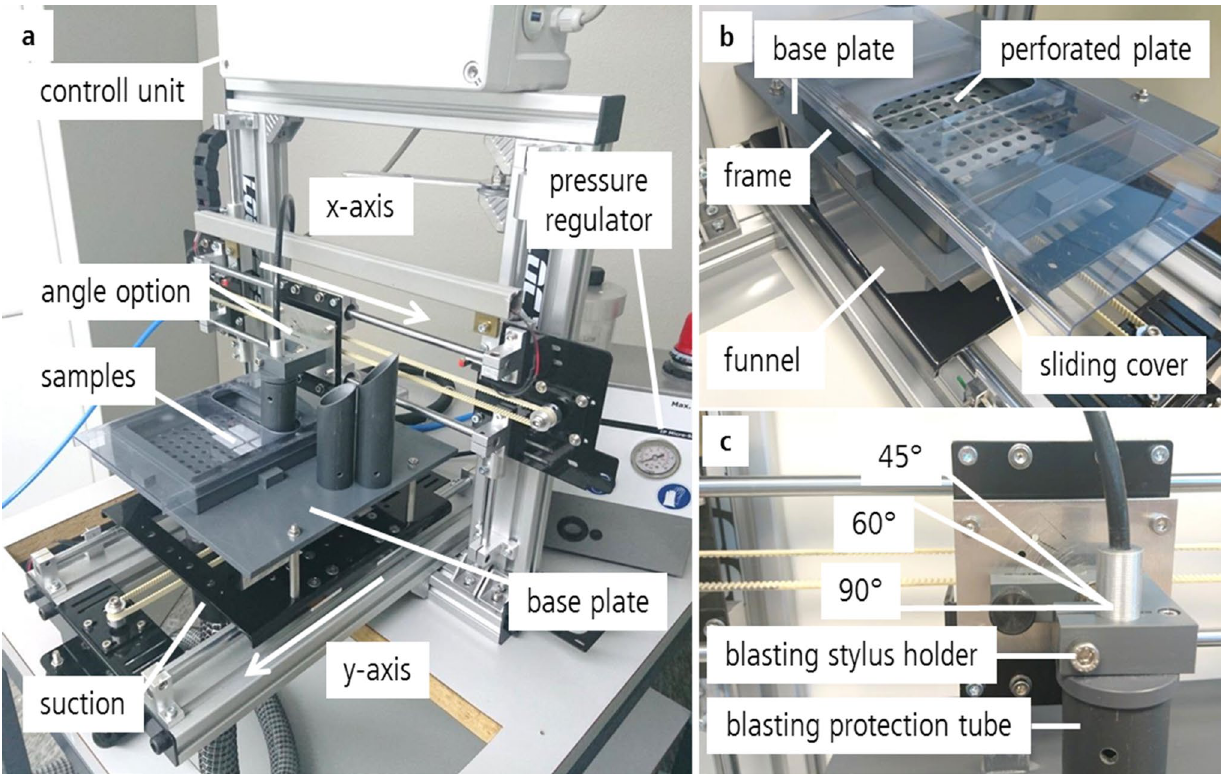
Fig. 1 Custom-built automated sandblasting machine ( a ), with y-axis baseplate component details ( b ) and adjustable blasting angle set-up ( c ) Fig. 2 Adjustment of the work- ing distance using individual spacers for each angle ( a ), sandblasting path with parallel blasting lines 1 mm apart and the profilometry path was per- pendicular to the sandblasting path ( b